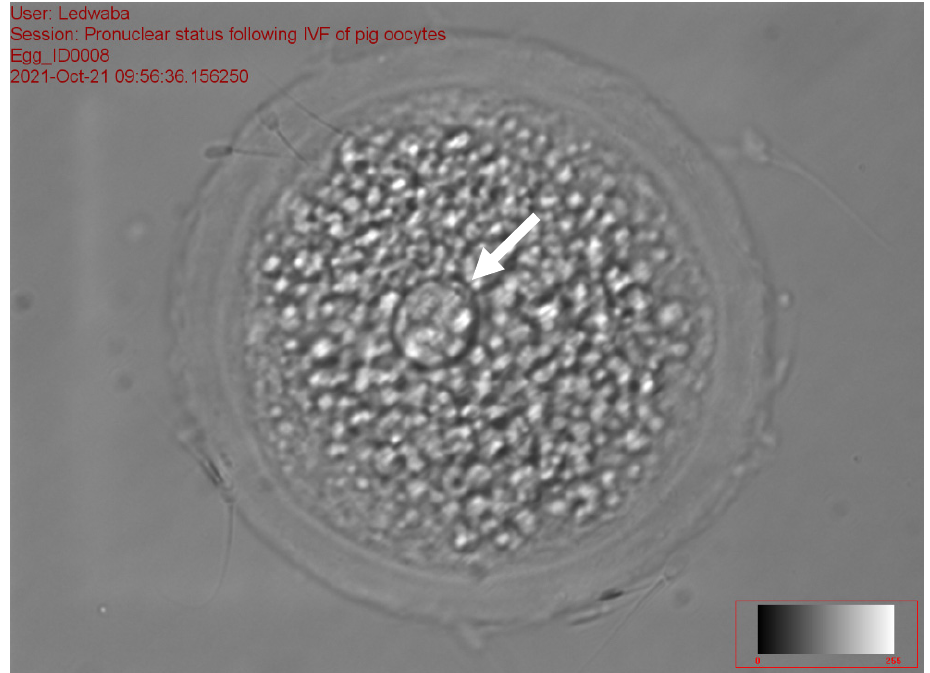
Figure 3. Zygote with the arrow showing 1 PN following in vitro fertilization at 40× magnification.